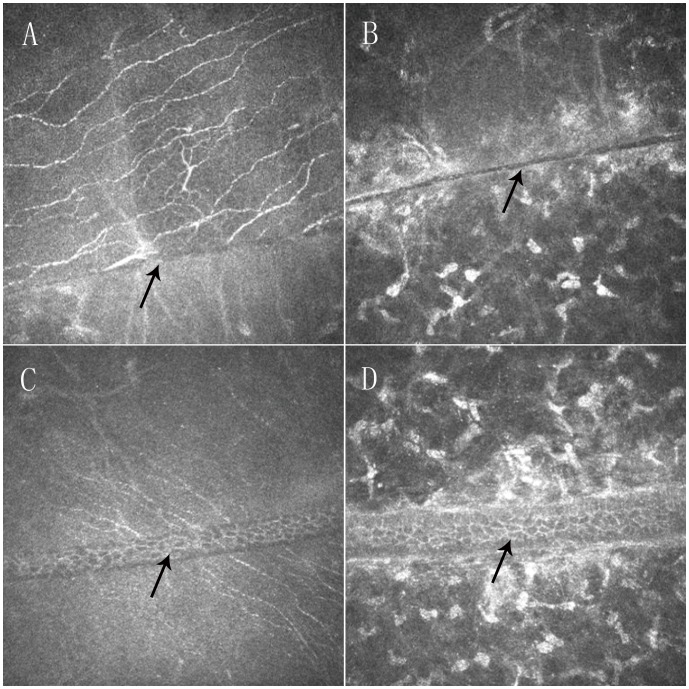
Confocal microscopy (HRT III) images showing clear and well-defined cap margins (A, B) and flap margins (C, D) 6 months postoperatively.Epithelial cells (arrows) were observed at the flap margins (C, D). The space between the margins was wider in FS-LASIK-treated eyes than in SMILE-treated eyes. Field size: 400 µm×400 µm.